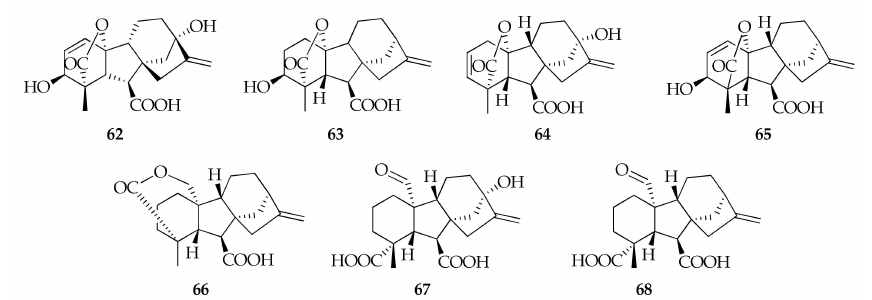
Figure 15. Structures of gibberellins.